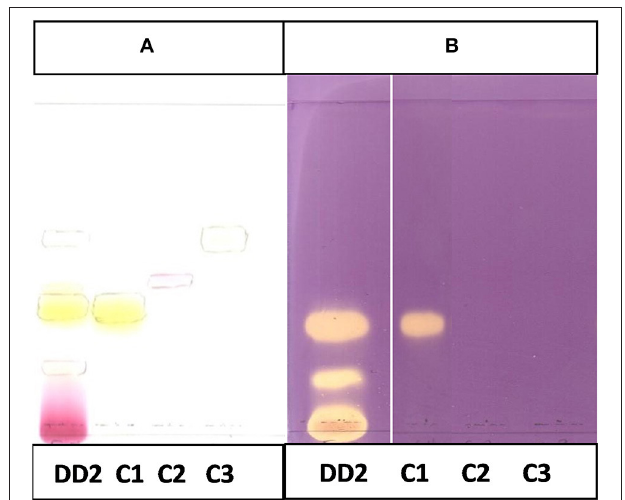
FIGURE 10 | (A) Chromatogram developed in CEF (7:3:0.5) of sub fraction DD2 and the 3 compounds sprayed with vanillin. (B) Chromatogram developed in CEF (7:3:0.5) of sub fraction DD2 and the 3 compounds sprayed with